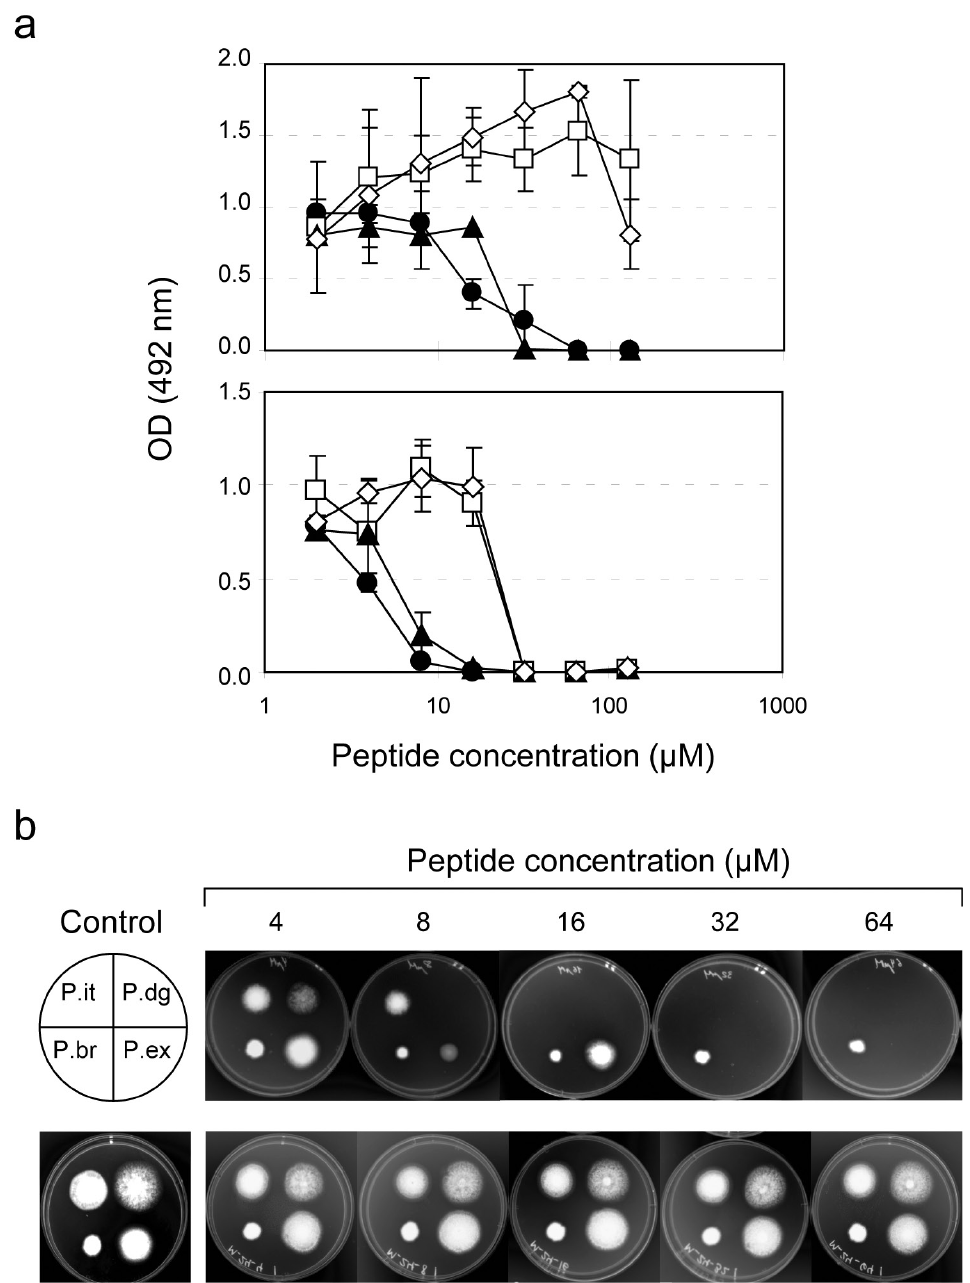
Figure 3. In vitro inhibitory and fungicidal activity of antimicrobial peptides towards Penicillium isolates. (a) Conidia of P. italicum PHI-1 ( ● ), P. digitatum PHI-26 ( ▲ ), P. brevicompactum PHI-8 ( □ ) and P. expansum PHI-65 ( ◊ ) were cul- tured in PDB in the presence of increasing concentrations of PAF26 (top panel) and melittin (bottom panel). Samples were prepared in triplicate, and data show the mean values ± SD of the OD at 492 nm at each peptide concentration, at 48 h of incubation. (b) Conidia of each fungus in a water solution were exposed for 24 h to the different peptide concentrations shown of PAF26 (top panel) and melittin (bottom panel), diluted and applied onto peptide-free PDA plates to monitor fungal